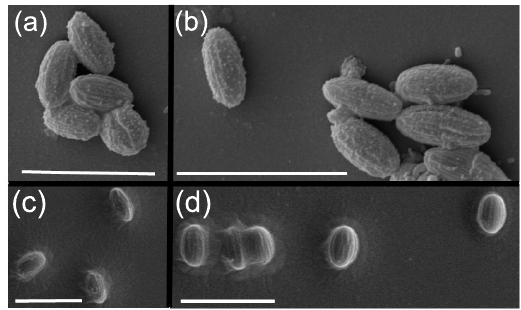
Figure 5. SEM images of prolate ellipsoids, obtained by stretching of the spherical PCPMMA colloids by ( a , b ) 90%; and ( c , d ) 70%. The scale bar lengths are 5 µ m.